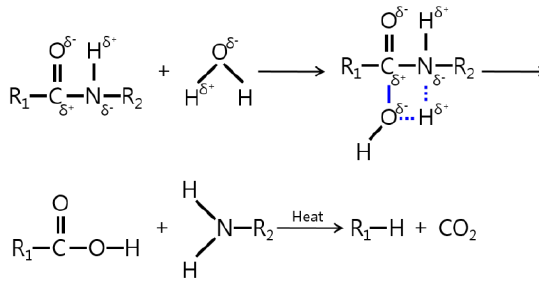
Figure 2. Hydrolysis of polyamide (adopted from Reference [37]).